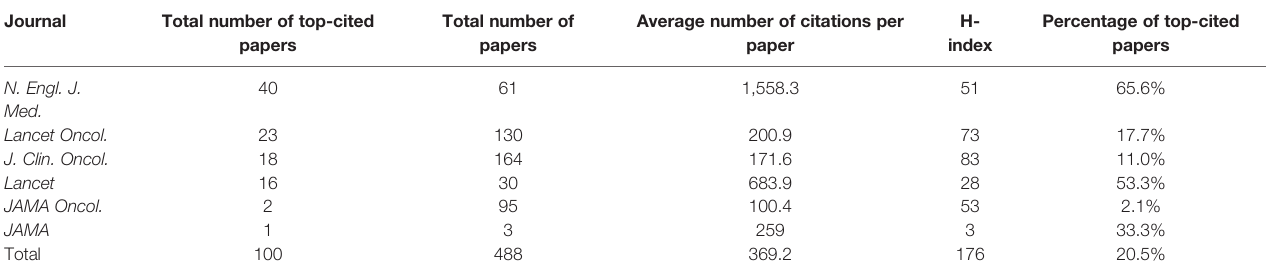
TABLE 2 | Citation analysis of papers on anti-PD1/PDL1 immunotherapy published in major journals between 2010 and